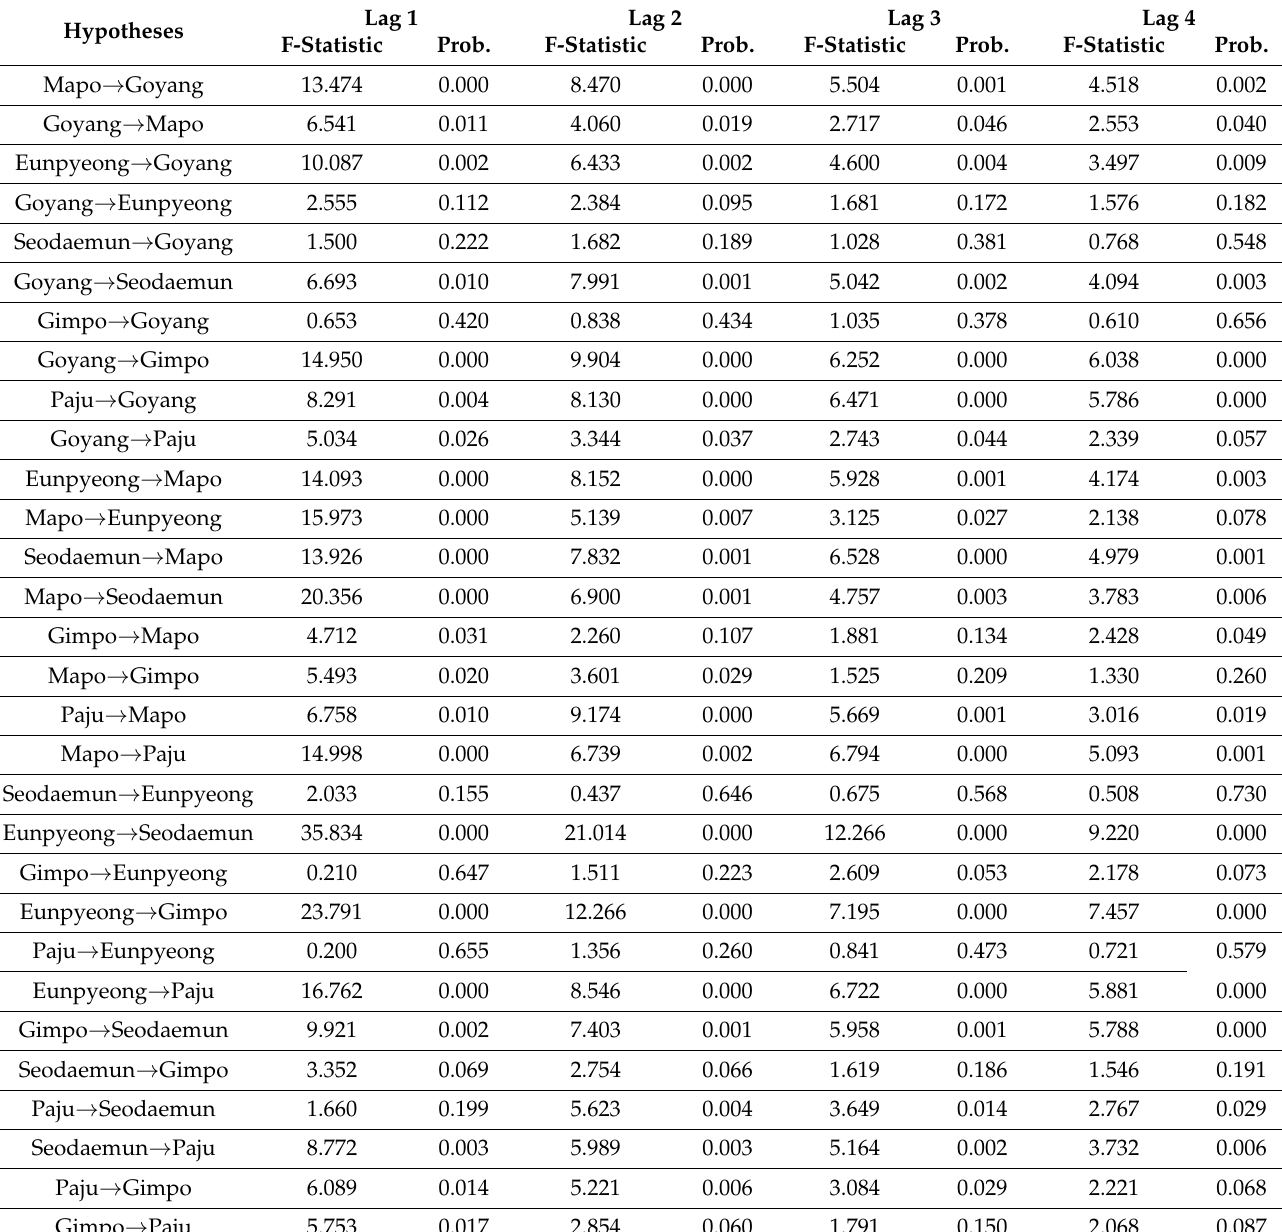
Table 6. Granger causality analysis of jeonse prices in Northwest and Gyeongeui